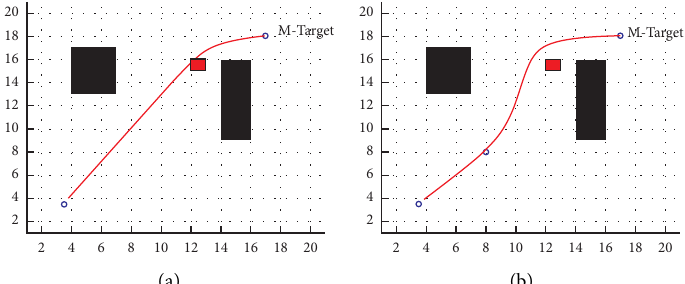
Figure 20: Schematic diagram of simulation results before and after adding real-time obstacle avoidance strategy. (a) Collision situation. (b) Obstacle avoidance situation.